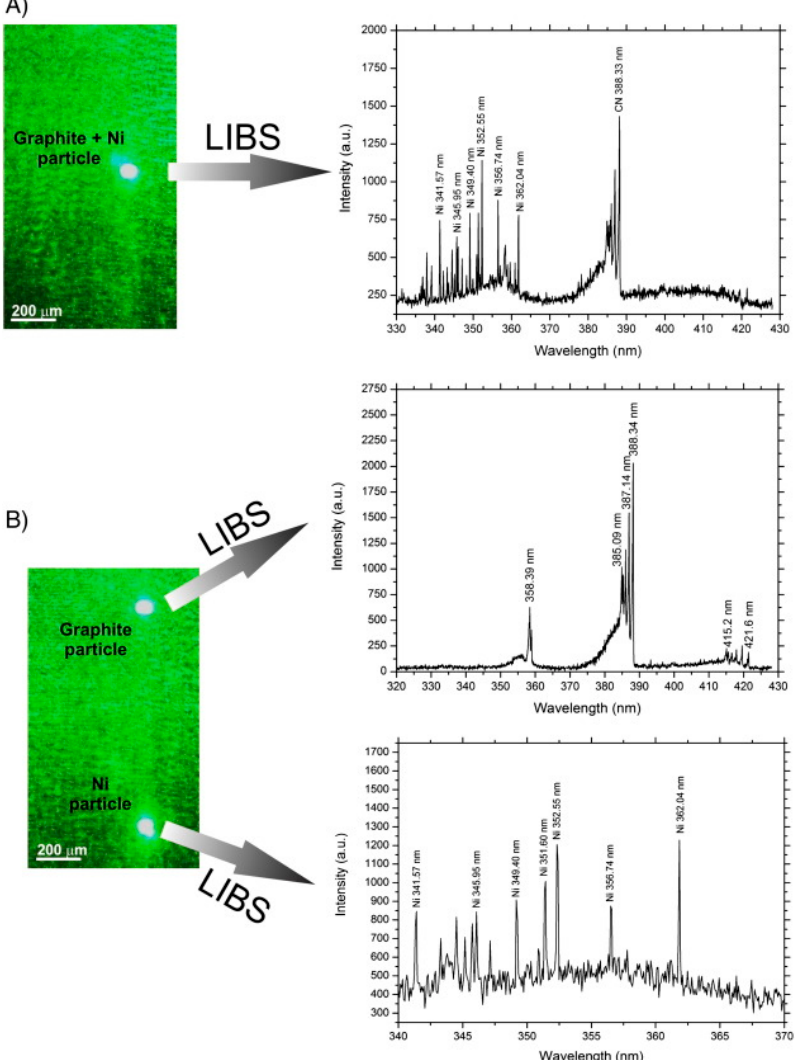
Figure 10. LIBS spectra of a non-homogeneous mixture from 50% graphite and 50% nickel spheres when ( A ) trapped particles are closely spaced in the same focal region and ( B ) trapped particles are properly manipulated and isolated from each other. The main emission lines are labeled in the spectra. (Reprinted with permission from [194]. Copyright (2014) Elsevier). The latest generations of OT-LIBS systems (e.g., Figure 11), with an increased excita- tion efficiency for small particles, where air–mass plasma acts as the main source of exci- tation over direct laser–particle interaction, have pushed the limit of detection down to 58.9 attograms [195] and later to an extreme sensitivity of 37 attograms [196] for copper nanoparticles. In fact, in this system, the dissociation and excitation processes are directed by heat transmission from plasma to particle and mass transfer the other way around.